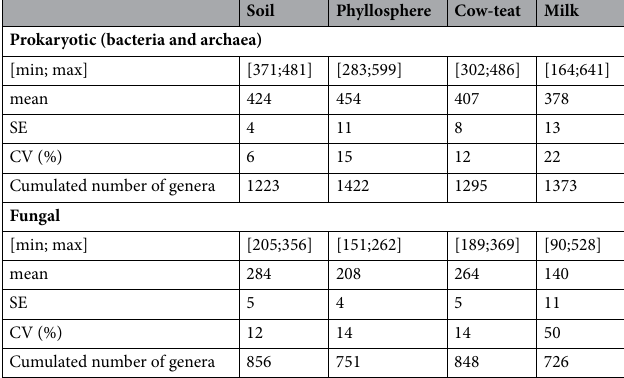
Table 2. Summary statistics of genera number by compartment.